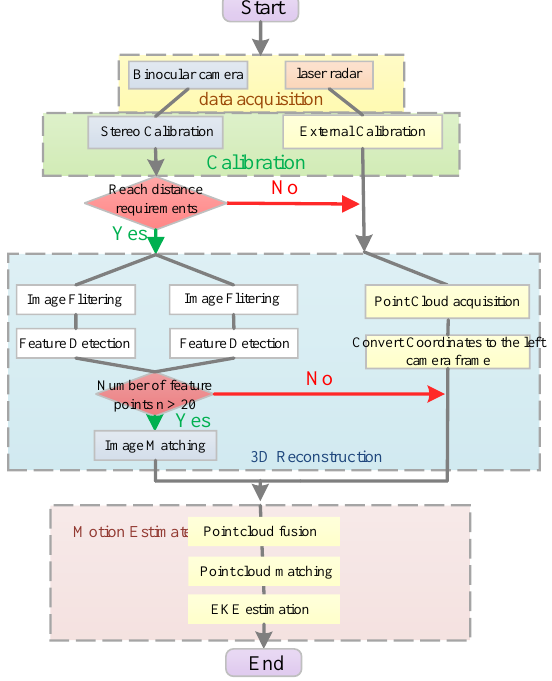
Figure 27. Schematic diagram of visual + laser coupling measurement.